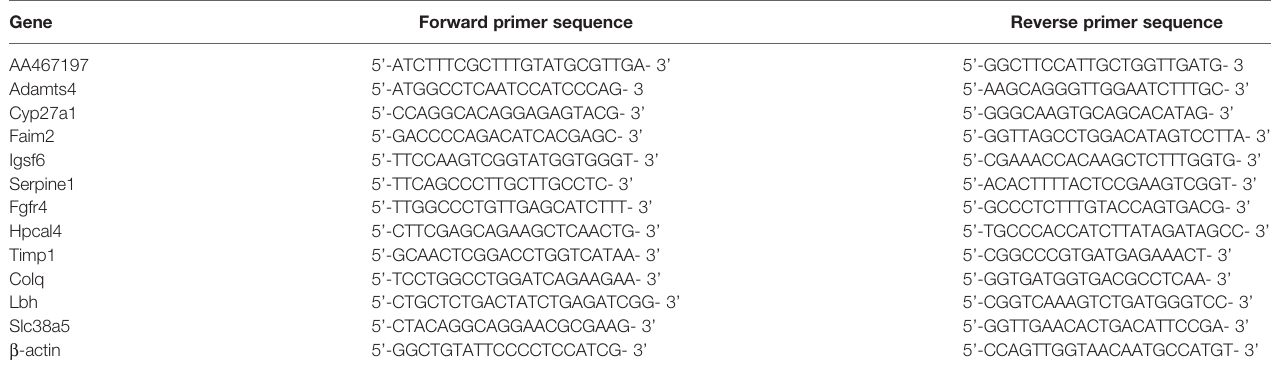
TABLE 1 | Primers sequences used for qRT-PCR in this